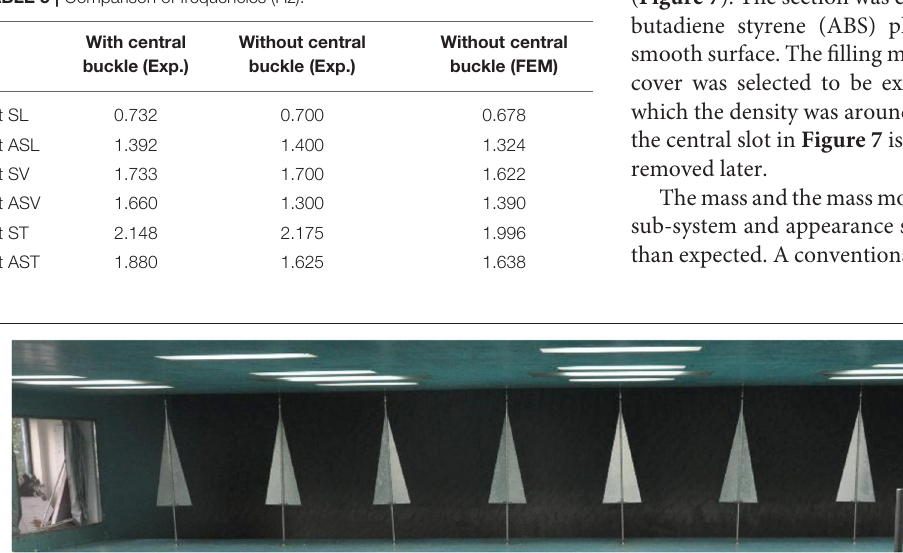
TABLE 5 | Comparison of frequencies (Hz).